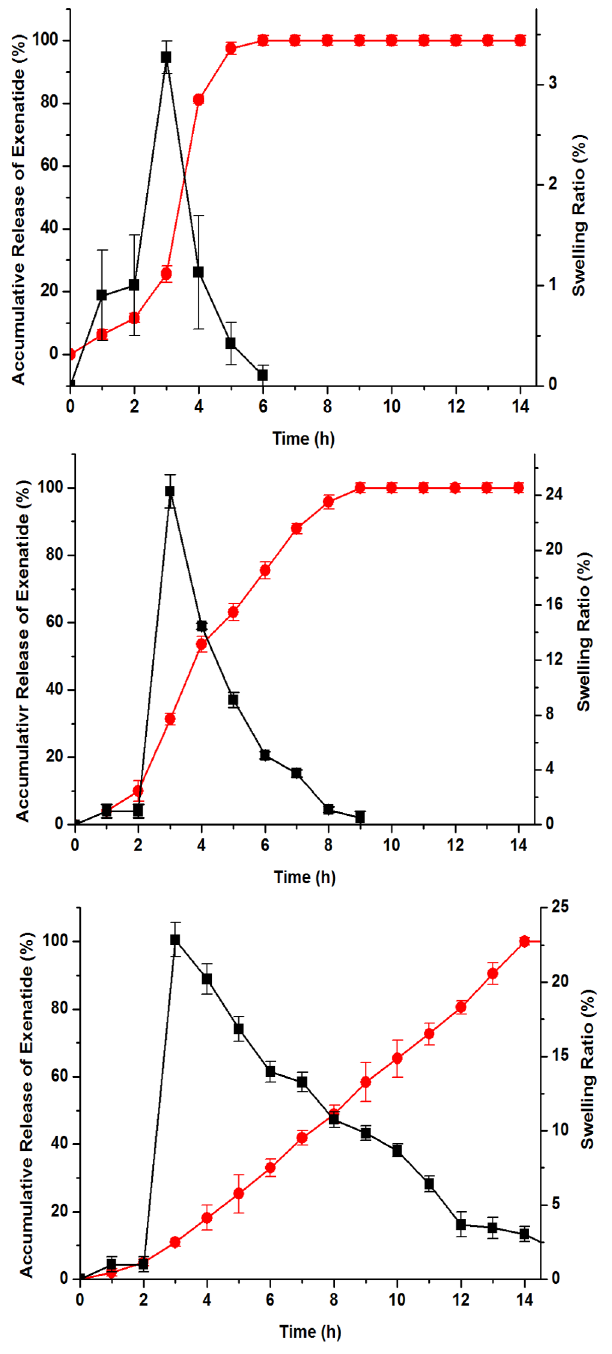
Figure 3. Dissolving and swelling characteristics of different microsphere preparations. (A) Cross-linking for 0.5 h. (B) Cross- linking for 1 h. (C) Cross-linking for 2 h. All black squared curves depicted by line and symbol represent the changes of swelling ratio and red circled curves show the changes of exenatide release. The experiments were conducted in 0.063 N HCl solutions (pH 1.2) for the first 2 h and then transferred to 0.1 M sodium phosphate solution (pH 7.4). Data are averages of three independent experiments and error bars represent standard deviations.